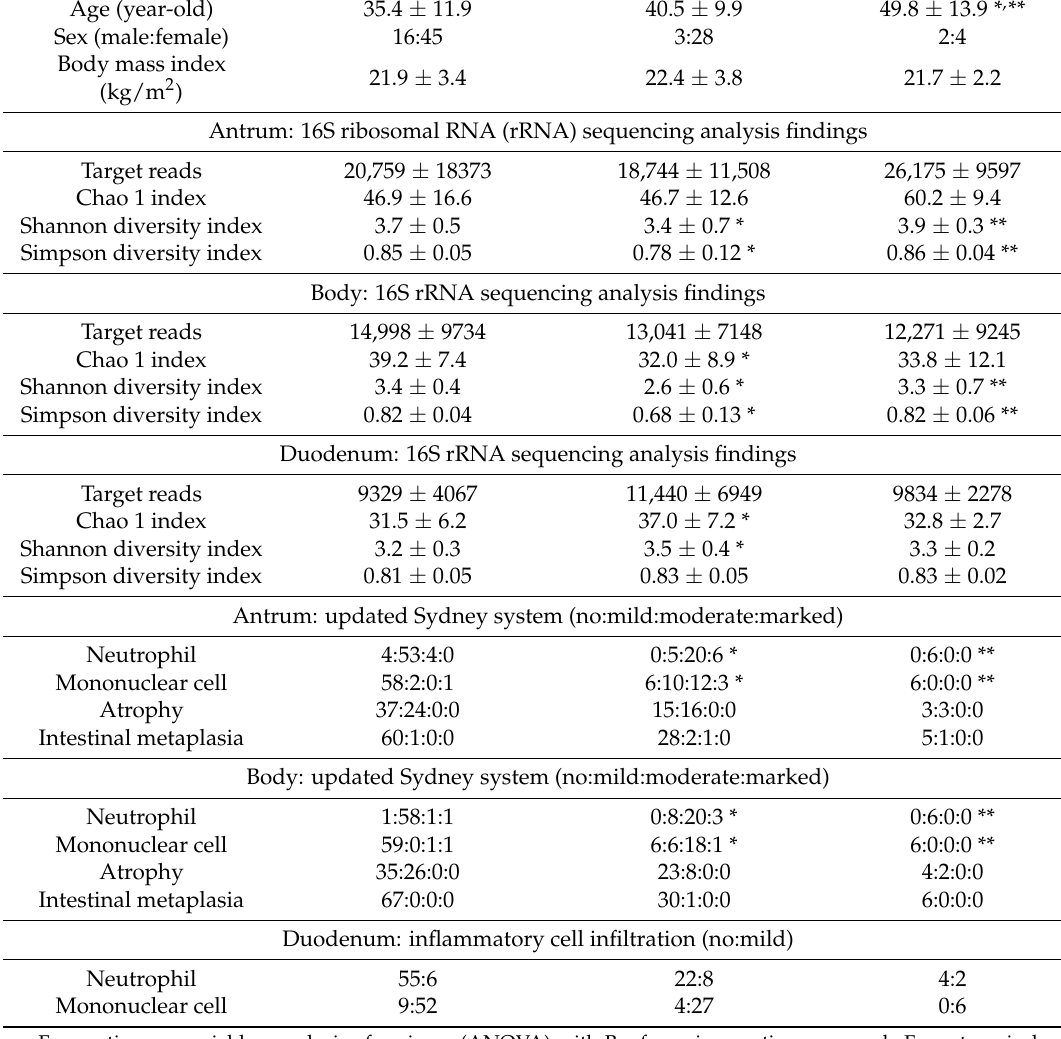
Table 1. Differences between subjects according to the status of Helicobacter pylori infection.